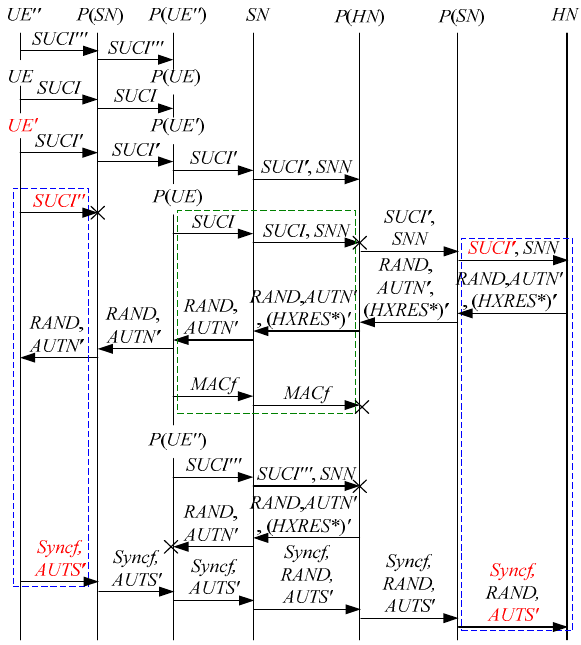
Figure 21. The twentieth attack scenario of the 5G AKA protocol.